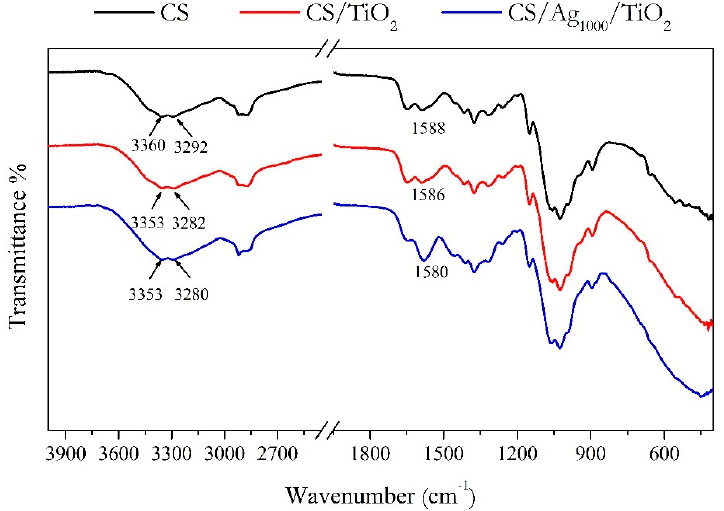
Figure 1. FTIR spectra of Chitosan (CS), Chitosan/TiO 2 (CS/TiO 2 ) and Chitosan/silver 1000 ppm/TiO 2 (CS/Ag 1000 /TiO 2 ).